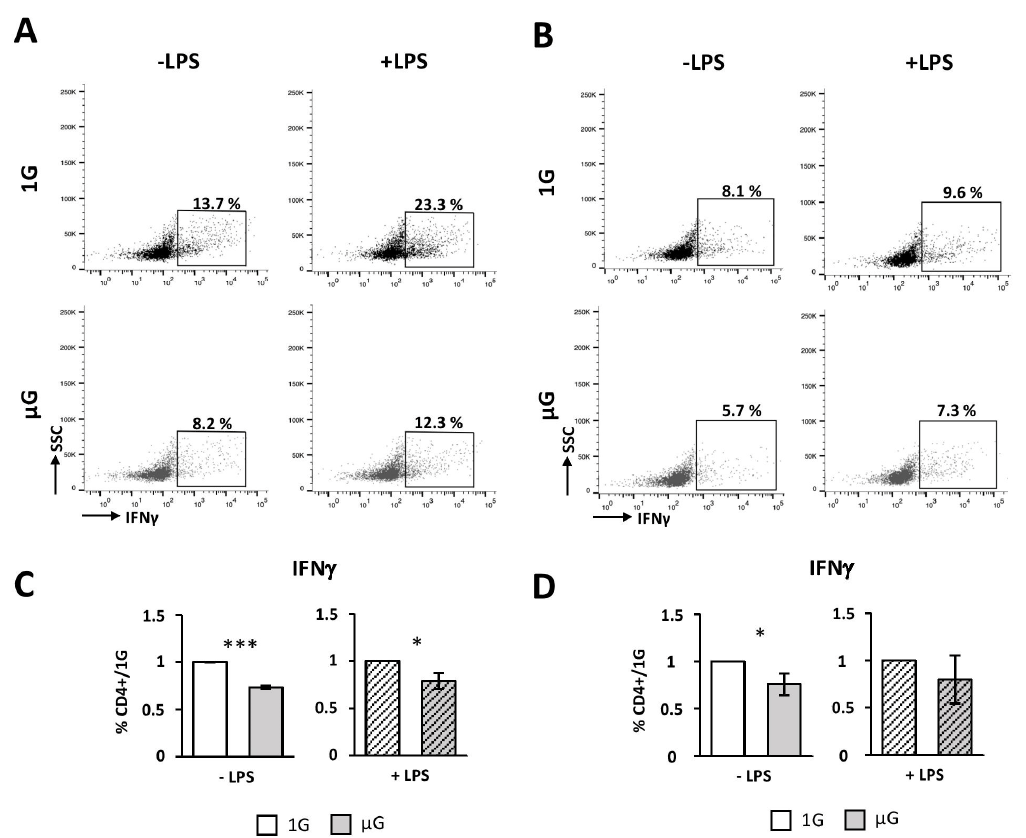
Figure 6. Simulated microgravity impairs the ability of DCs to polarize CD4+ T cells towards Th1 profile. Splenic DCs were isolated from mice and cultured for 24 h in the absence (1G) or presence ( µ G) of simulated microgravity with (+LPS) or without ( − LPS) LPS and then pulsed with ovalbumin peptide (ova 323-339 ) ( A , C ) or full protein ( B , D ). DCs were then co-cultured for 4 days with CD4+ T cells isolated from OTII mice. On day 4, T cells were re-stimulated for 6 h with PMA/ionomycin in the presence of Golgi inhibitor. Production of IFN γ was determined by intracellular staining followed by flow cytometry. ( A , B ) Representative FACS dotplots are shown from three ( A ) or four ( B ) independent experiments. Numbers in the quadrant represent the percentage of IFN γ -producing CD4+ T cells for each condition. ( C , D ) Mean ± SEM of 3 independent experiments, 1G values were set as 1. Data from three ( C ) or four ( D ) independent experiments were normalized and are expressed as fold differences relative to 1G cells. T-test or Mann–Whitney test was used to reveal statistically significant differences. * p < 0.05; *** p < 0.001.